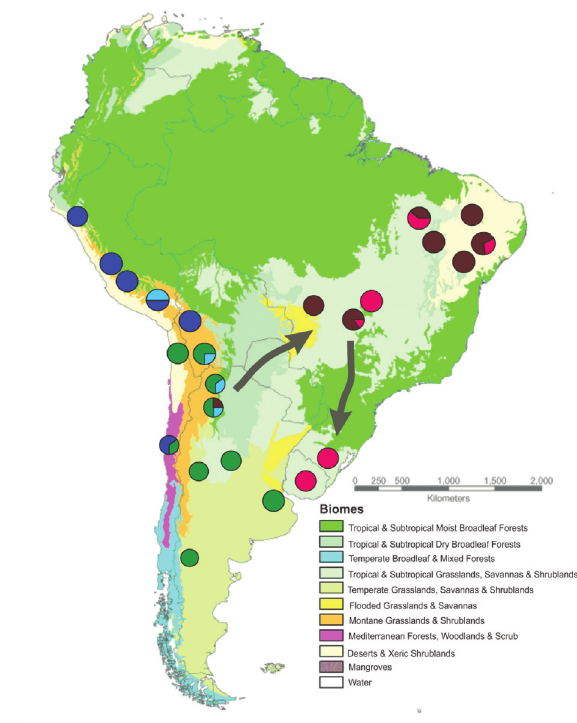
Figure 4 - Map of South America showing the major genetic groups iden- tified throughout the analyzed L. colocola distribution. The circles repre- sent each sampling location, and the colors indicate the relative presence of haplotypes associated with each of the genetic groups identified with the BAPS analysis: Group 1 – central and north-eastern Brazilian L. colocola + L. tigrinus (brown); Group 2 – southern Brazilian and Uru- guayan L. colocola + L. tigrinus (pink); Group 3 – south-western L. colocola (green); Group 4 – north-western L. colocola (dark blue); and Group 5 – central-western L. colocola (light blue). The arrows indicate the predominant direction of migration between populations based on analy- ses performed with the software LAMARC. Neotropical biomes are de- fined according to Olson et al.